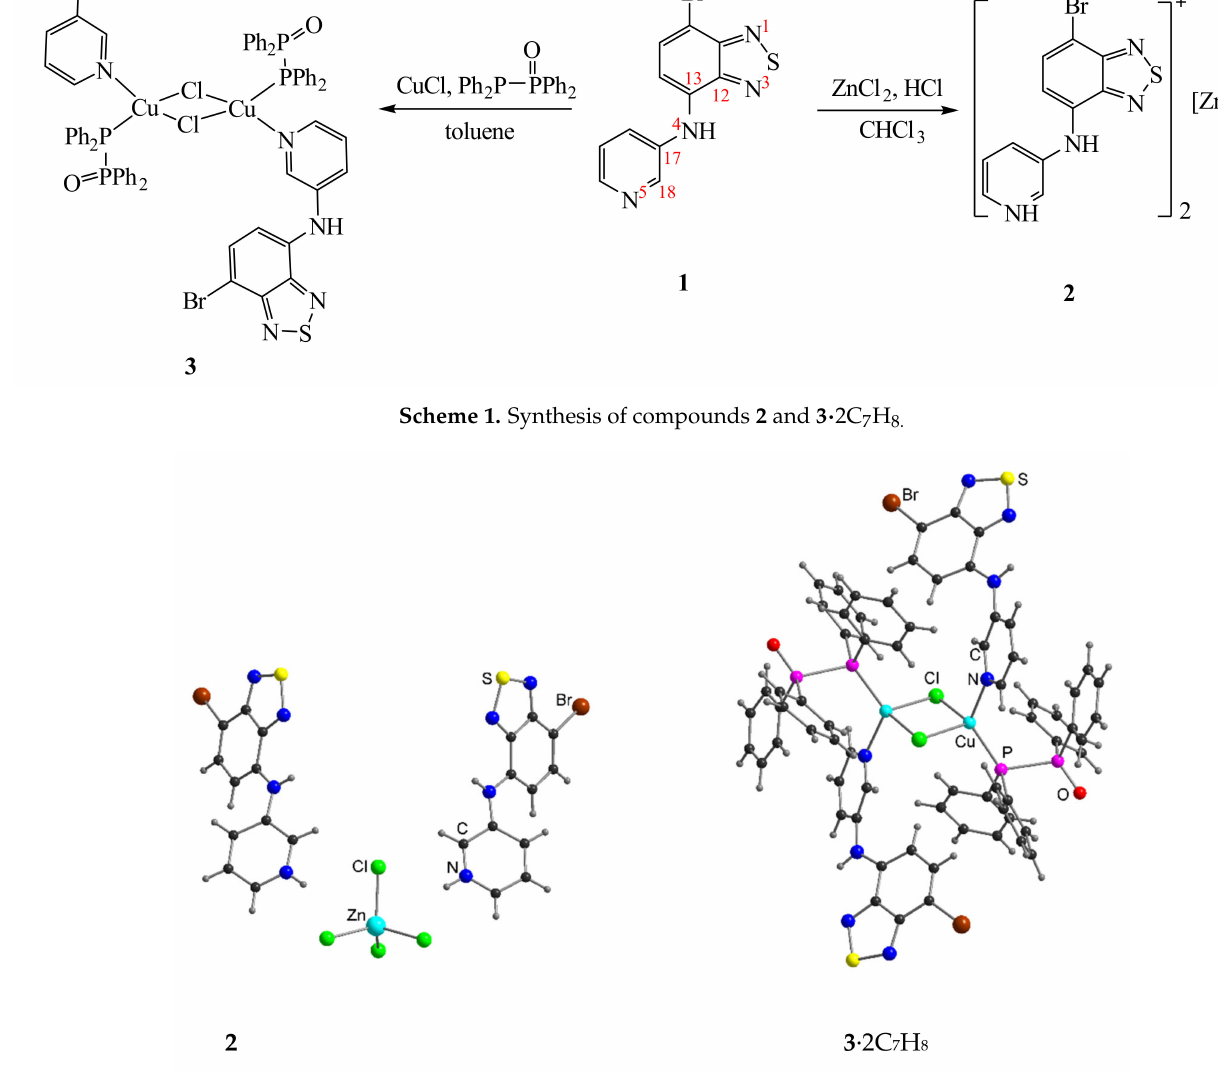
Figure 1. Structure of compounds 2 and 3 · 2C 7 H